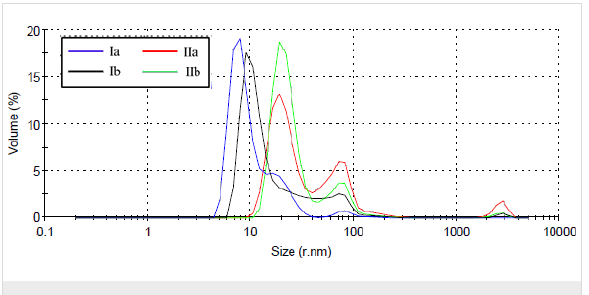
Figure 5: Histogram analyses of the particle size distribution by volume of fullerene–steroid derivatives Ia,b and IIa,b